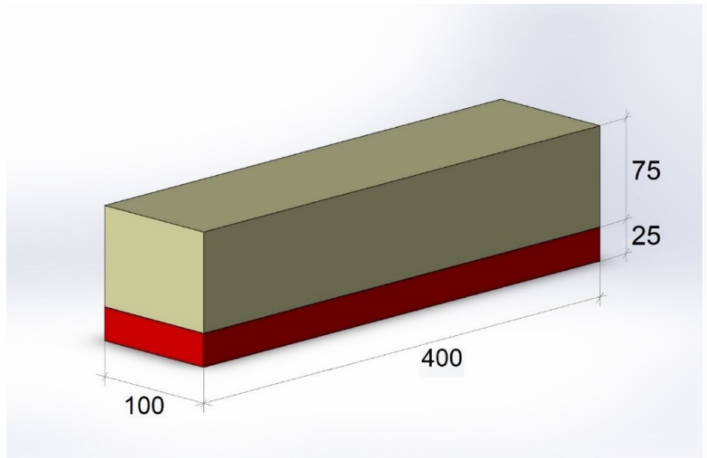
Figure 11. Fiber distribution in the prism of Group